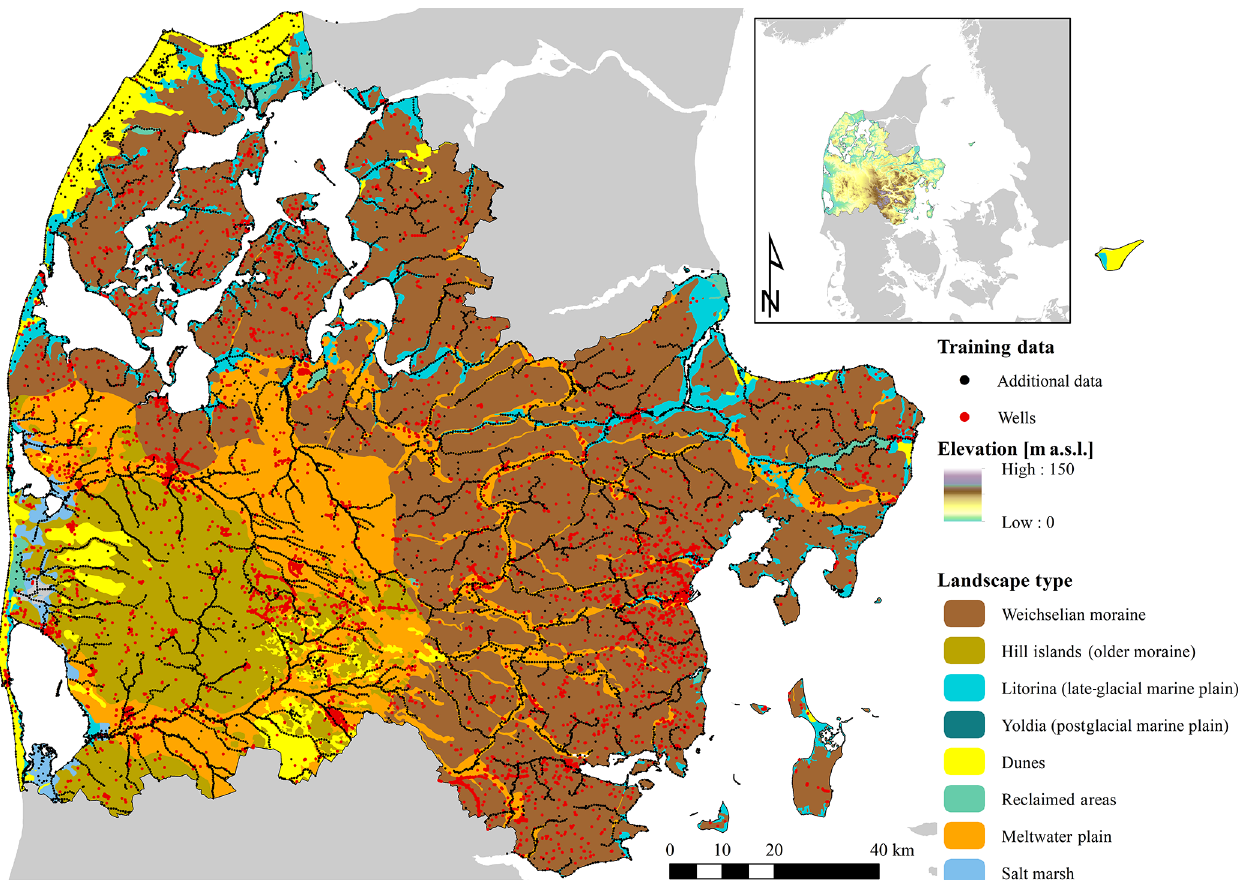
Figure 1. The study site is located in central Denmark. The inset figure is an overview depicting the digital elevation model. The main map shows the predominant geological landscape types. The training dataset contains observations at ∼ 15000 wells. Additionally, ∼ 16000 artificial observations, placed along major rivers, lakes and the coastline, are added to the analysis. The depth to the shallow groundwater is set to zero for the additional